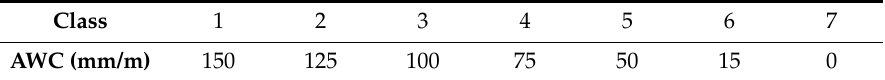
Table 1. Available water capacity (AWC) value and classification.